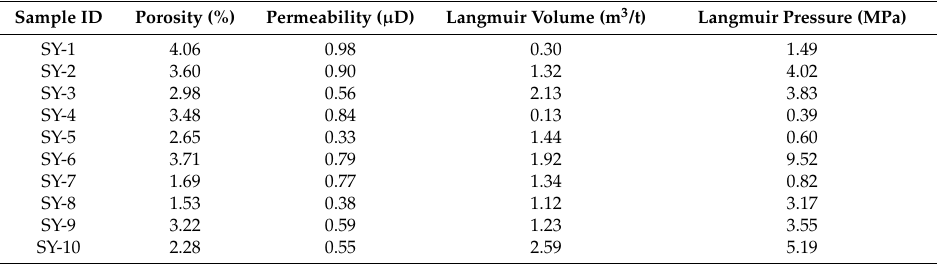
Table 3. Porosity, permeability and methane adsorption results for the shale samples.